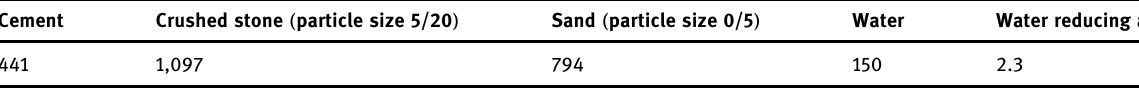
Table 1: Concrete matrix mix proportion ( kg/m 3 )